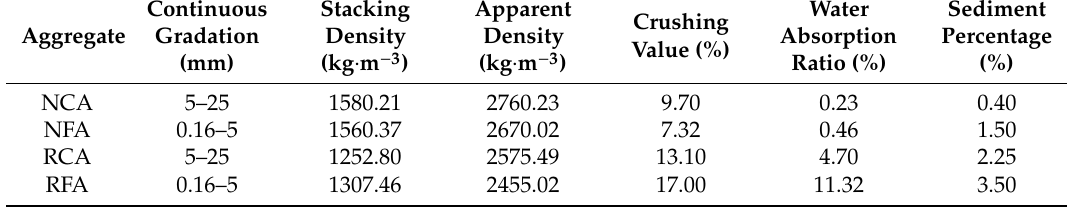
Figure 3. Particle size distribution of the RCAs and RFAs.